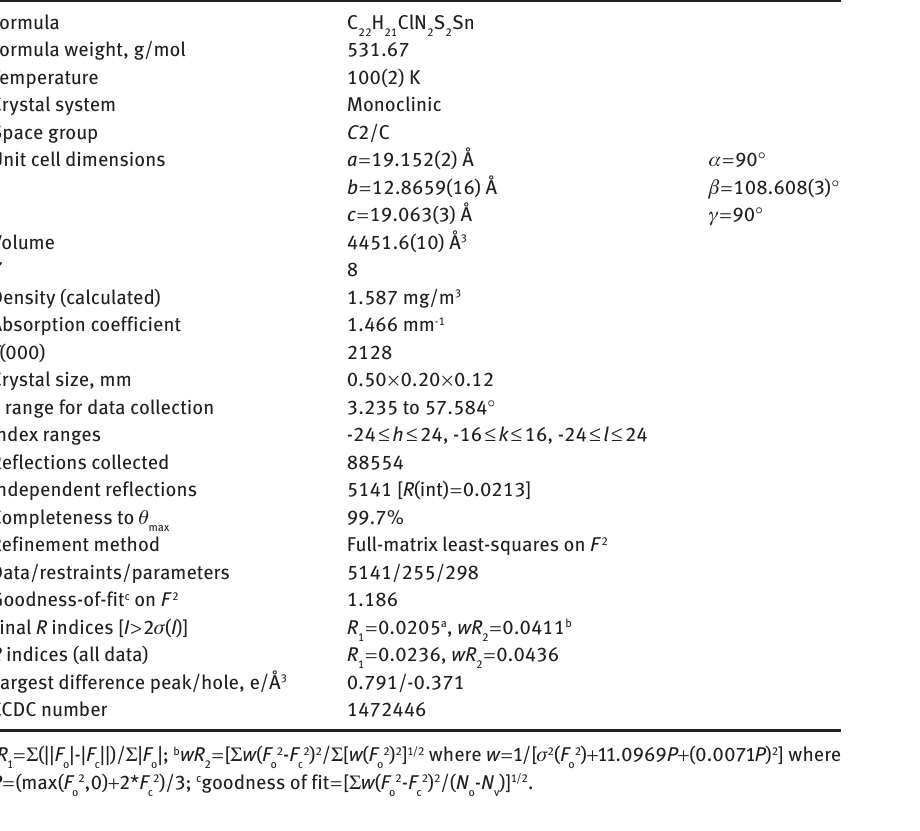
Figure 1: Molecular structure of [ClPh scheme [Ortep views. A) Showing the two positions of the dimethyl N -cyanodithioiminocarbonate ligand, B) showing the positioning between two